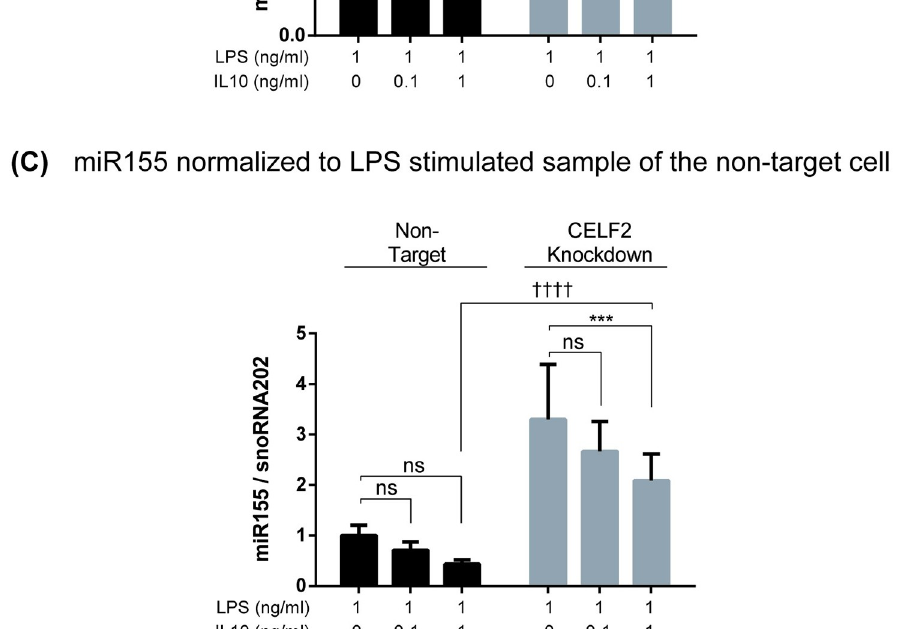
Fig 4. Knockdown of CELF2 impairs IL10 inhibition of miR155 and increase basal level of miR155 in response to LPS. RAW264.7/Cas9 cells transduced with CELF2 sgRNA or non-target sgRNA were treated with 2 μ g/ml doxycycline to induce knockdown of CELF2 protein. (A) CELF2 protein expression was determined by immunoblotting. Data plotted represents CELF2 protein band intensity normalized to GAPDH in three independent experiments (unpaired Student’s t test). (B) CELF2 or non-target knockdown cells were stimulated with 1 ng/ml LPS ± indicated concentration of IL10 for 4 hours prior to total RNA extraction. Expression level of miR155 was determined by real-time PCR and normalized to snoRNA202 levels. Data plotted represents the expression miR155 relative normalized to each cell’s own LPS stimulated sample or (C) qPCR data from B, but with all samples normalized to the LPS stimulated sample of the non-target cell. (Two-Way ANOVA with Tukey’s correction. The asterisk ( � ) were used for comparison within the same cell type and the dagger (†) were used for comparison between the different cell type, ���� p < 0.0001, ��� p < 0.001, �� p < 0.01, � p < 0.05, † p < 0.05, †††† p < 0.0001).